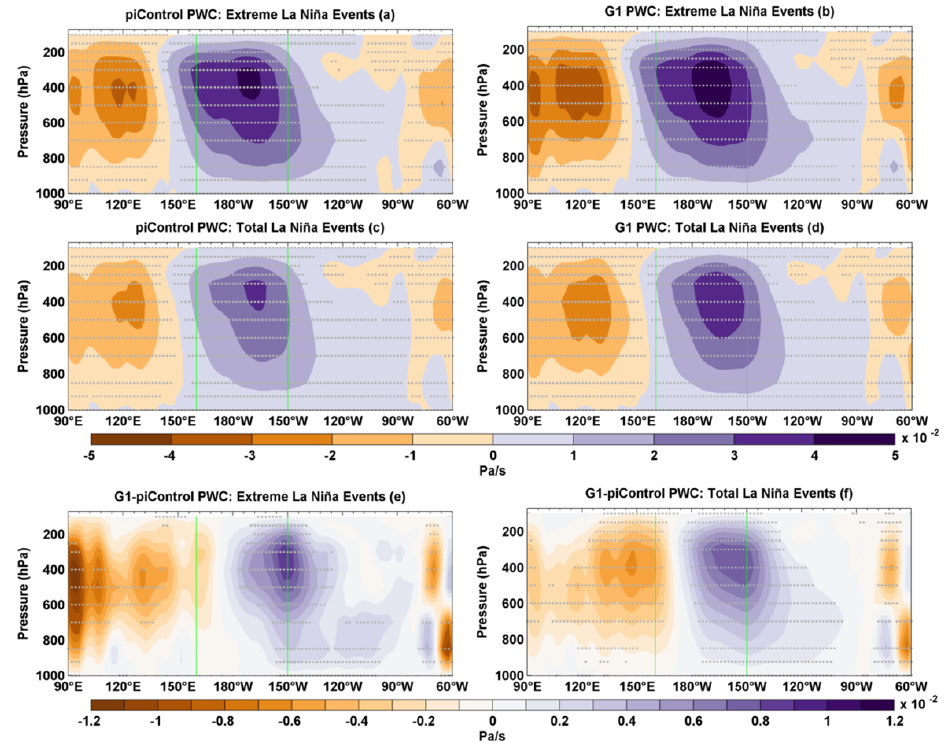
Figure 14. Composites of PWC anomalies for extreme La Niña events in (a) piControl and (b) G1. Composites of PWC for the total number of La Niña events in (c) piControl and (d) G1. Composite differences (G1 − piControl) of PWC anomalies for (e) extreme La Niña events and (f) the total number of La Niña events. Stipples indicate grid points with statistical significance at 99%cl using a non-parametric Wilcoxon rank-sum test. The vertical green lines indicate the Niño4